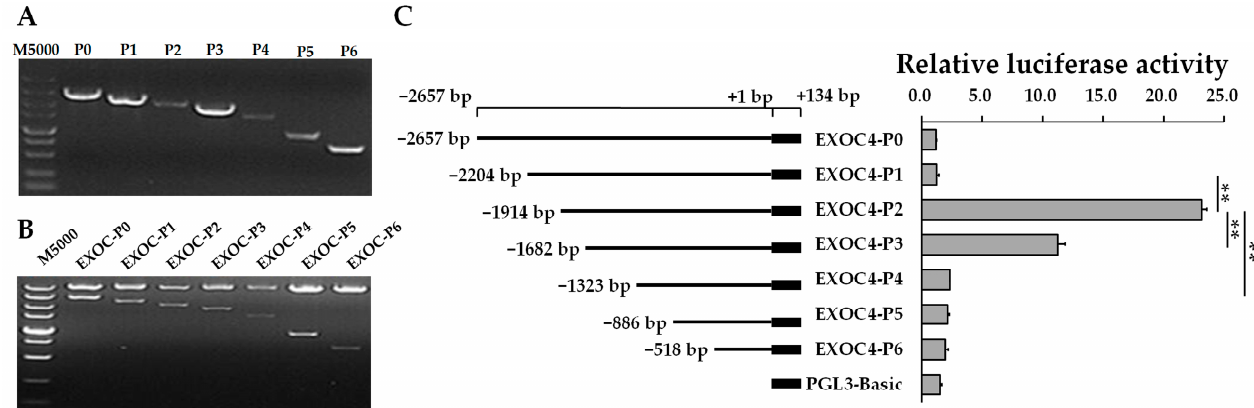
Figure 5. Transcription activity of the 5 ′ deletion fragment of the EXOC4 promoter. ( A ) PCR products of 5 ′ deletion fragments from EXOC4 promoter; ( B ) enzyme digestion identification of pGL3-vector with a deletion fragment of the EXOC4 promoter by restriction enzyme digestion; ( C ) the relative luciferase activity of the 5’ deletion fragment on the EXOC4 promoter. M5000: DNA marker of 5000 bp. ** indicates p < 0.01. Data are presented as means ± SD.